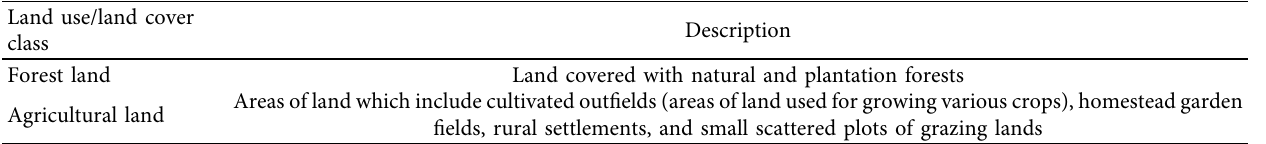
Table 2: Descriptions of land use/land cover types for the period